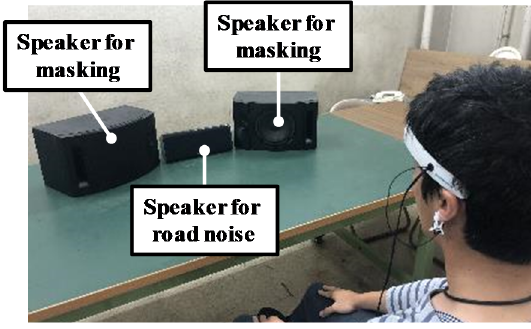
Figure 8. Photograph of heart rate meter.